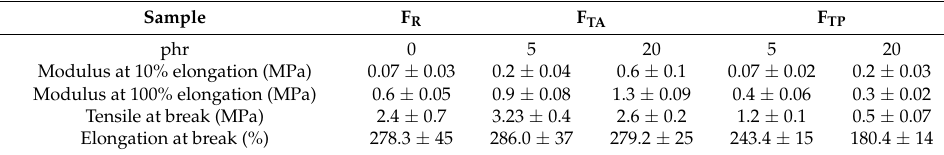
Figure 10. Stress ‐ strain curves of F TA and F TP mixtures at 5 and 20 phr at room temperature. Figure 1. Dumbbell-shaped specimens developed in our laboratory. Table 3. Mechanical parameters obtained from tensile tests at room